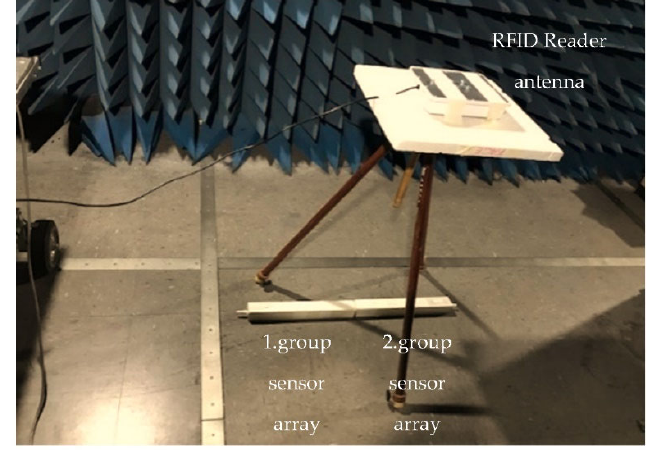
Figure 14. Twist line array test platform in an anechoic chamber.